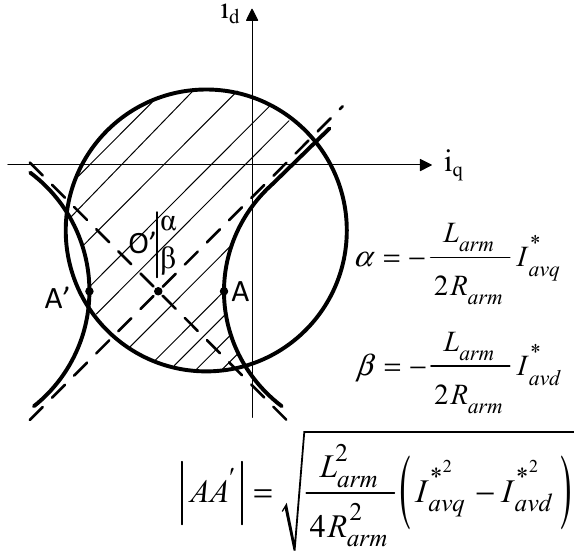
Figure 4. Stable operation region (hatched) for MMCs in STATCOM operating mode.